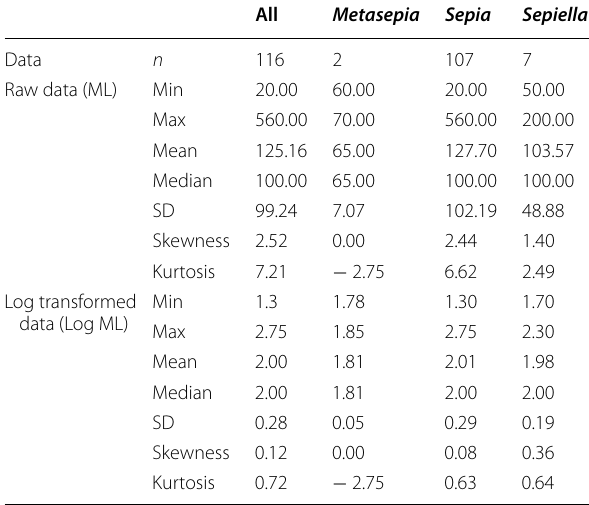
Table 2 Descriptive statistics of body size (ML mm and Log ML) for extant Sepiidae for all species together and for each genus of the